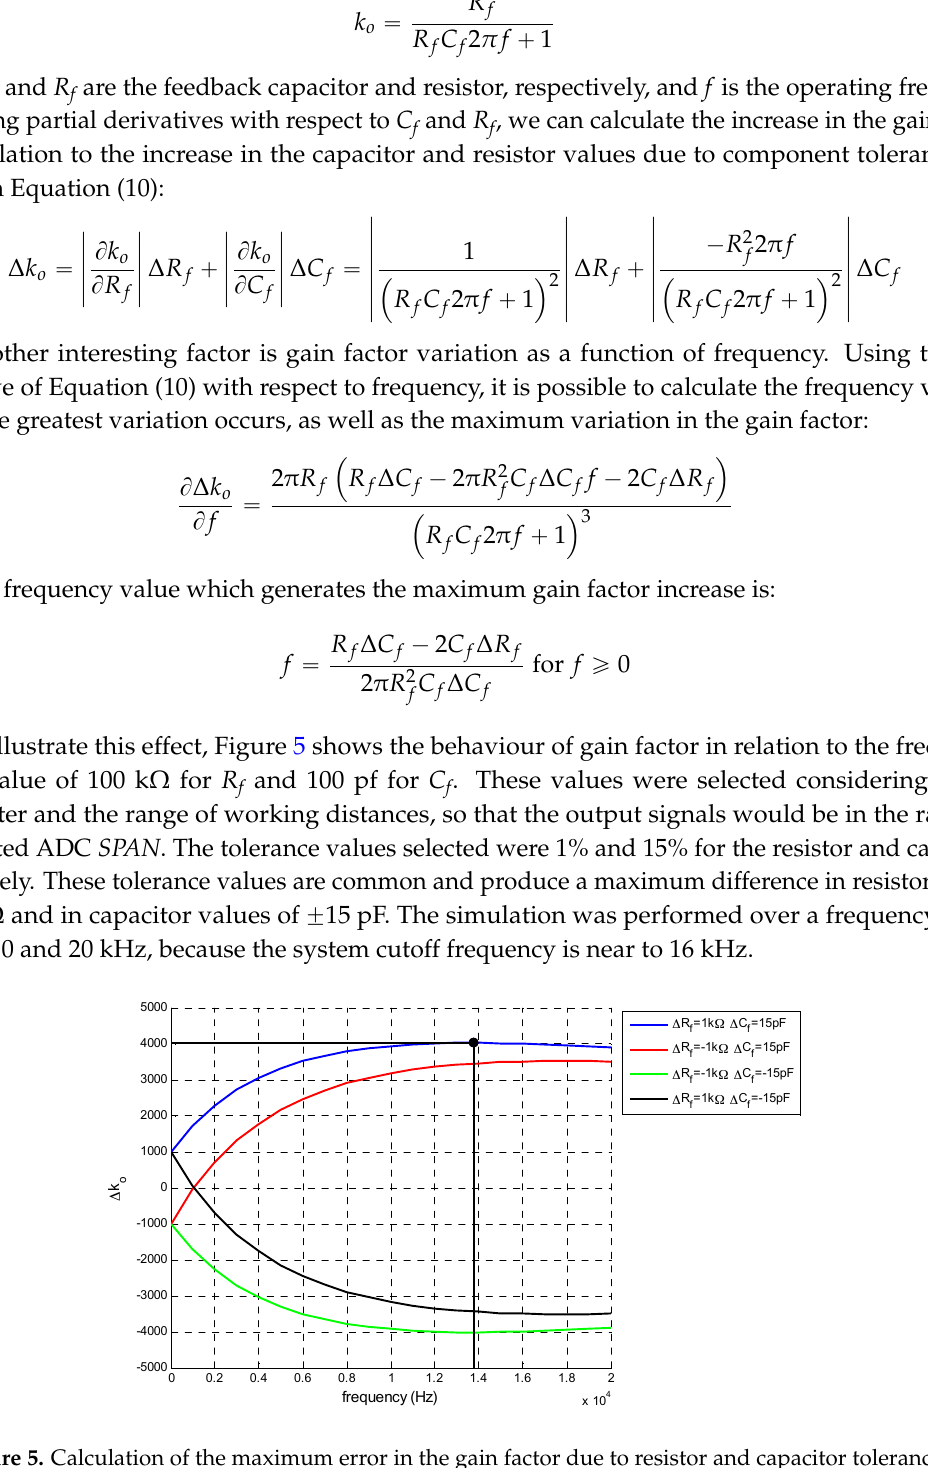
Figure 5. Calculation of the maximum error in the gain factor due to resistor and capacitor tolerances, in relation to the working frequency.